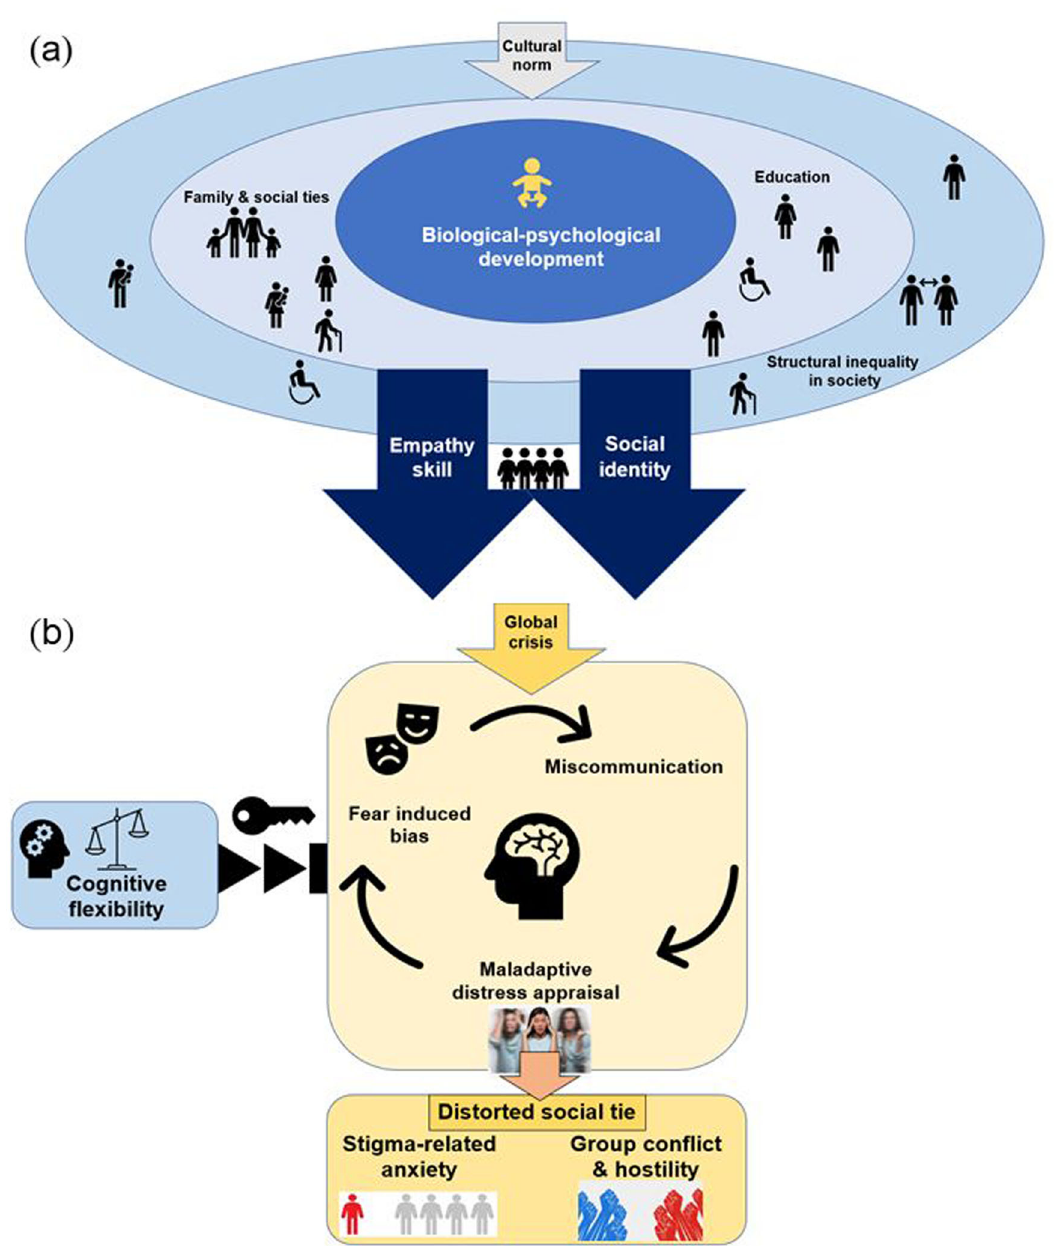
Fig. 1 Theoretical models of social tie, fear-induced bias and fl exibility. a Cognitive development of empathy skills and social identity and ( b ) Fear- induced bias and fl exibility. a Empathy skills and social identity may be nurtured by education and family/inter-personal connections, whereas they can also be affected by structural inequality in society. b Anxiety and con fl ict are characterised primarily by the catastrophic cycle of miscommunication, fear- induced bias and maladaptive distress appraisal. Meanwhile, cognitive fl exibility may help disengage from the cycle.